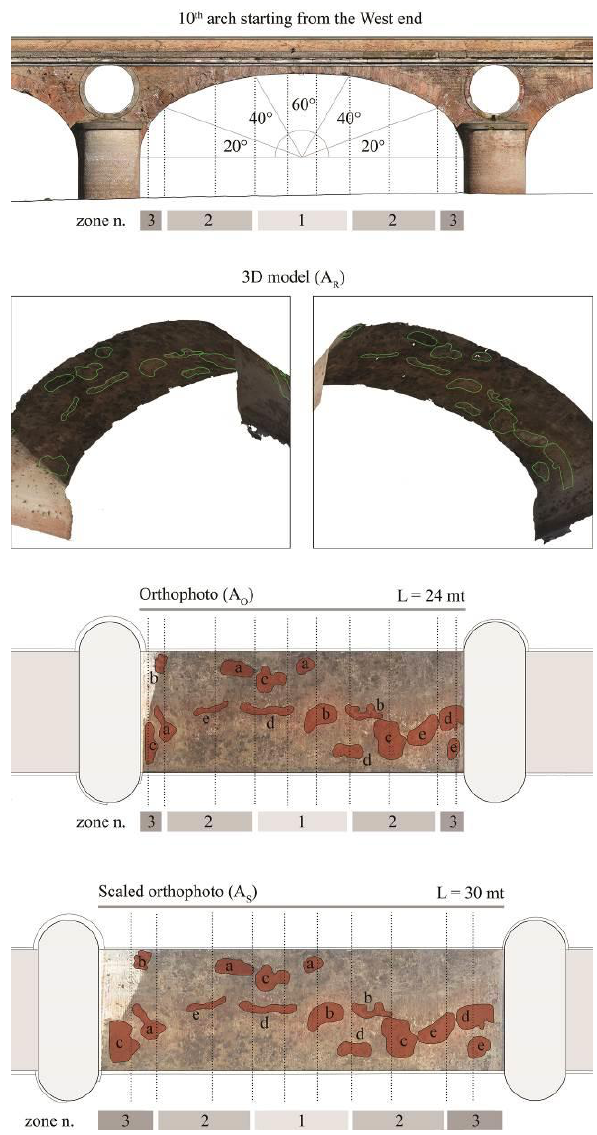
Figure 5. Mapping of decay on the 10 th arch (starting from the West end of the bridge) and measurement of fifteen areas through three different methods (using a 3D model, an orthophoto and a scaled